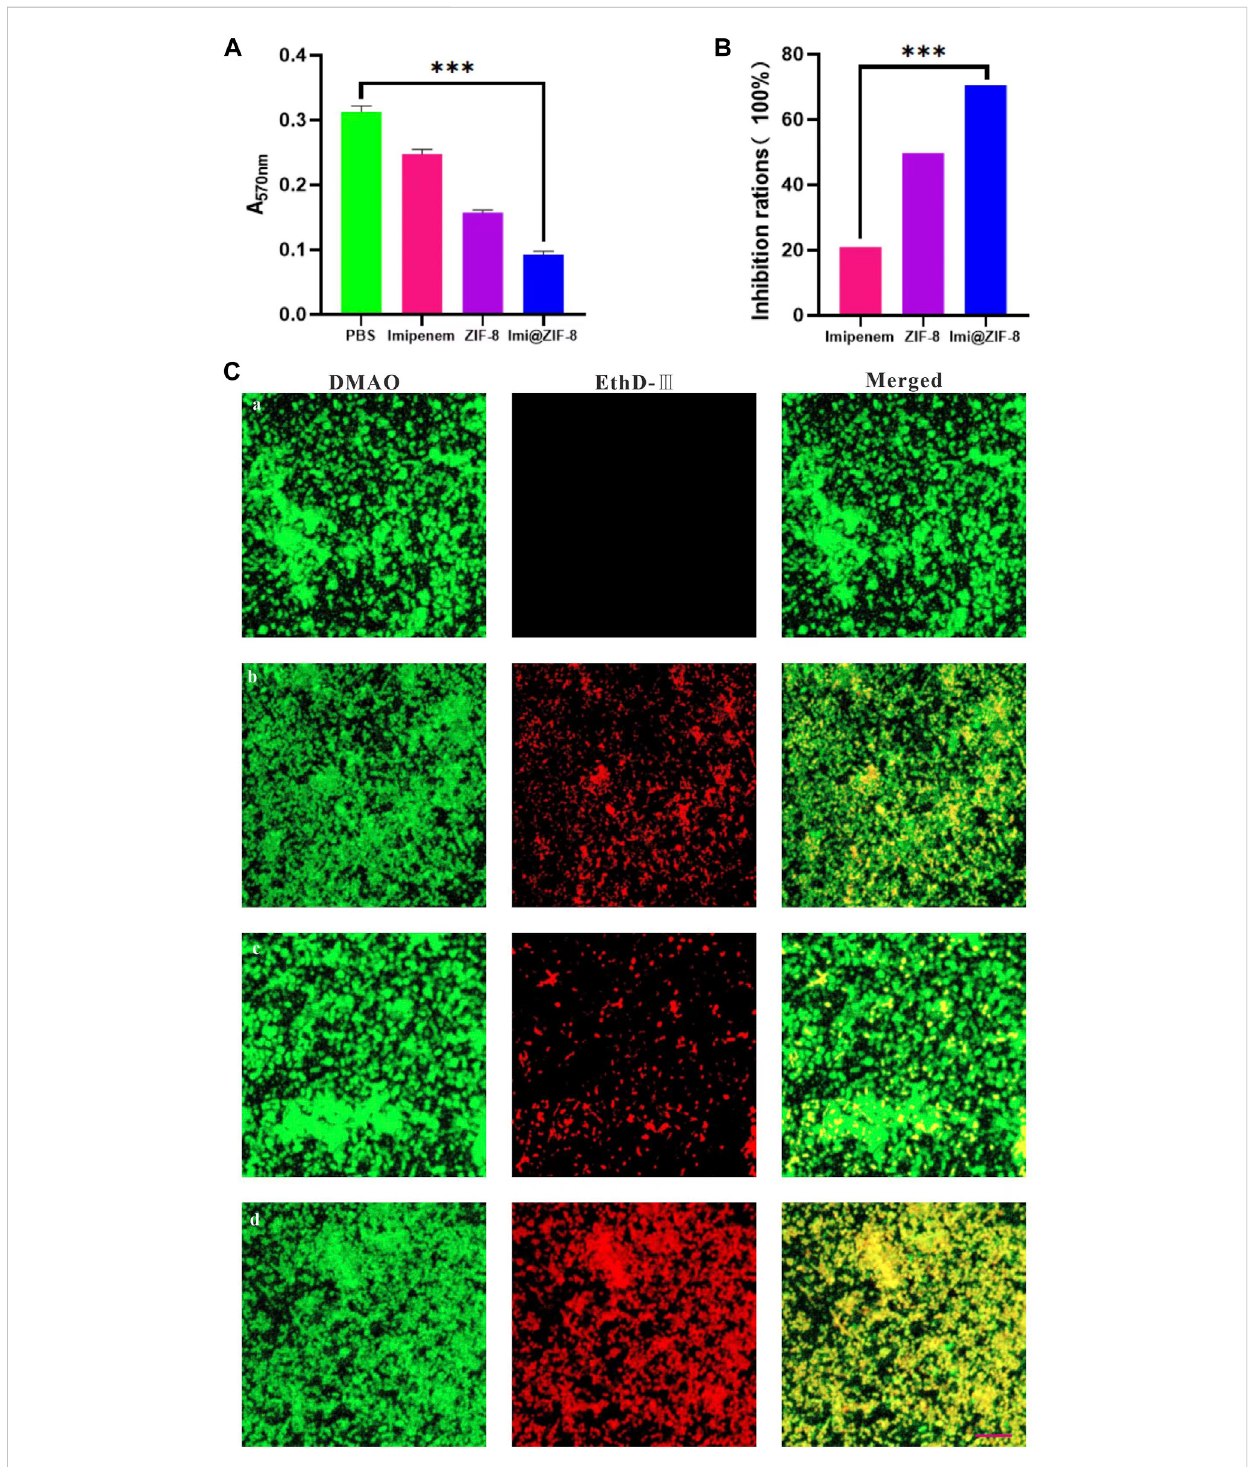
FIGURE 4 In fl uence of Imi@ZIF-8 on the bio fi lm formation and damage of A. baumannii . (A) CV staining analysis after receiving different treatments for 24 h. Theabsorbancevaluewasdetectedusinganenzymemarker(570 nm)tore fl ectbio fi lmformation. (B) CVstaininganalysis.Relativepercentageofbio fi lm inhibition. (C) CLSM images of A. baumannii bio fi lms treated with various treatments (PBS, imipenem, ZIF-8, or Imi@ZIF-8) for 24 h. Scale bar is 20 μ m. Data are indicated as mean ± SD ( n = 3). Compared to the PBS group: *** p < 0.001; Compared to the imipenem group: *** p <